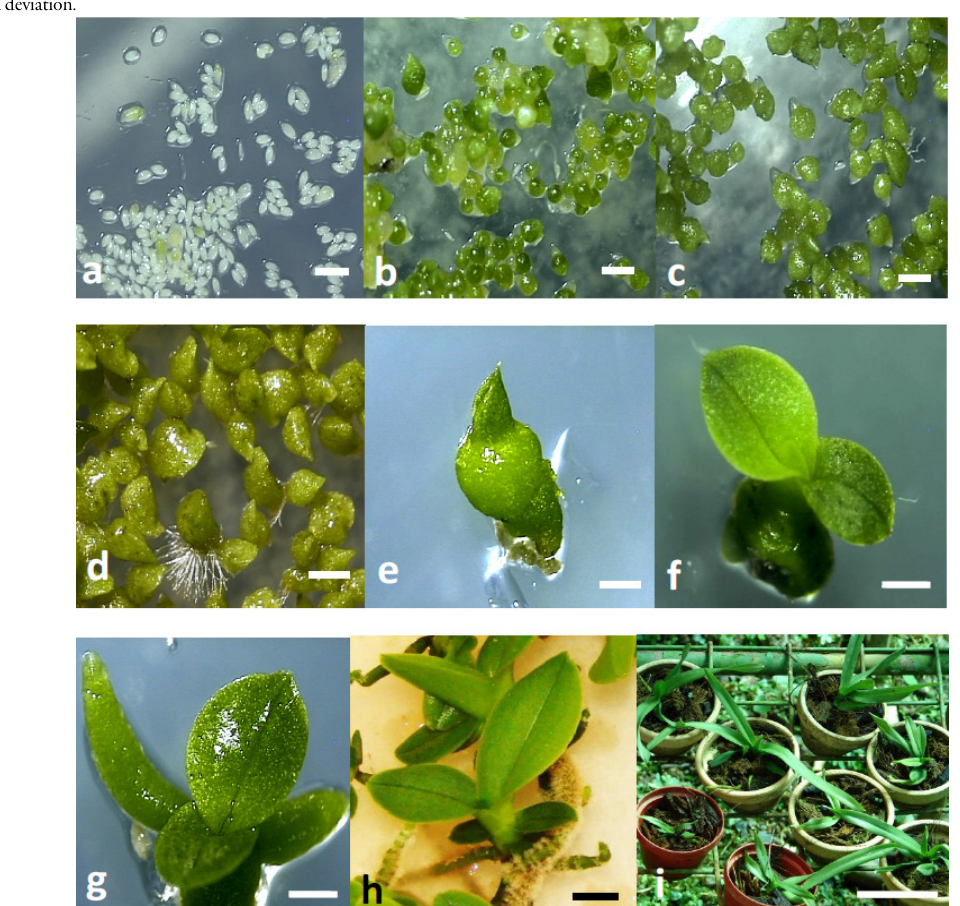
Fig. 2. Seedling development stages of Vanda helvola . (a) Seeds 10 days of culture. (b) Embryo enlarged after 20 days of culture. (c) Germinated seeds after 30 days of culture. (d) Protocorm at 40 days of culture. (e) Initiation of shoot from protocorm. (f) Protocorm with two leaves. (g) Established seedling with two leaves and two roots. (h) Seedling treated with 40% (v/v) tomato juice. (i) Acclimatized seedlings of Vanda helvola at Sabah Agriculture Park. Bar (a – h) 1.0 mm; (i): 5